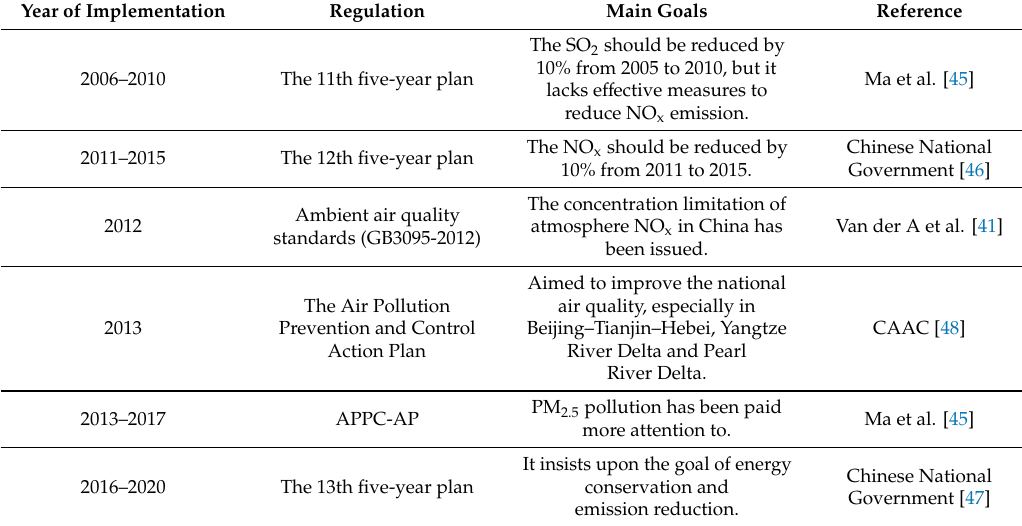
Table 1. Major environmental regulations over China in recent